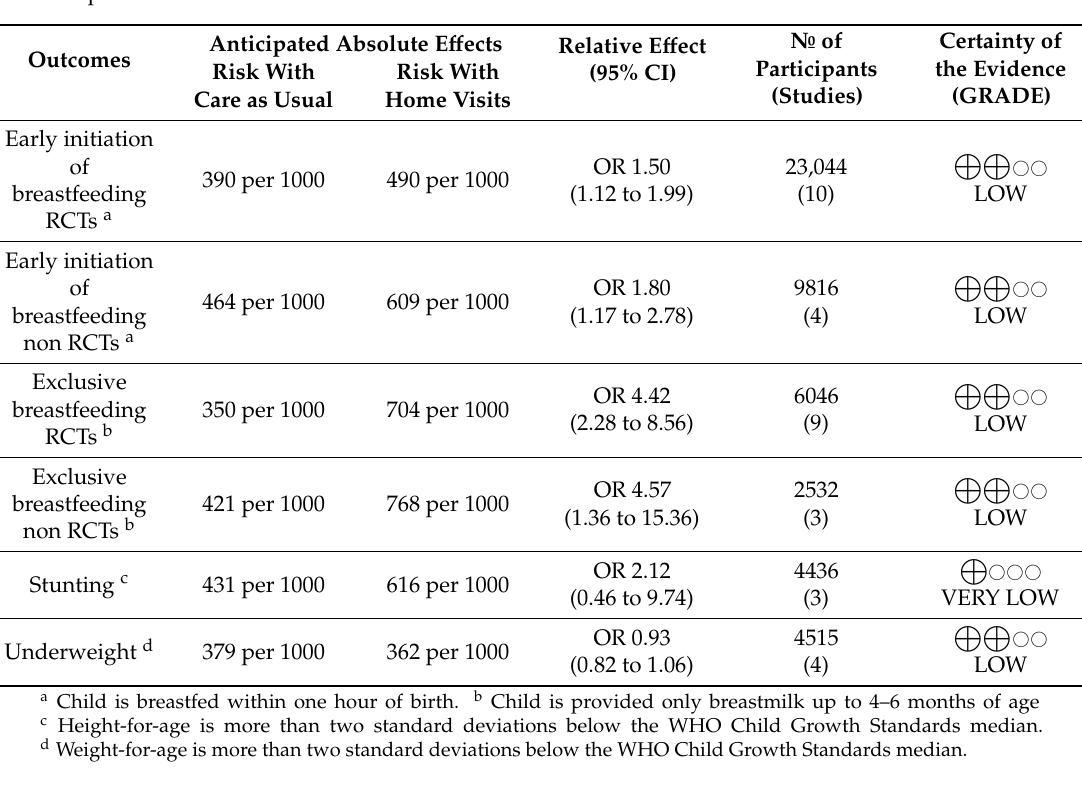
Table 1. Summary of outcomes for community healthcare worker (CHW) / peer counselor home visit platform.